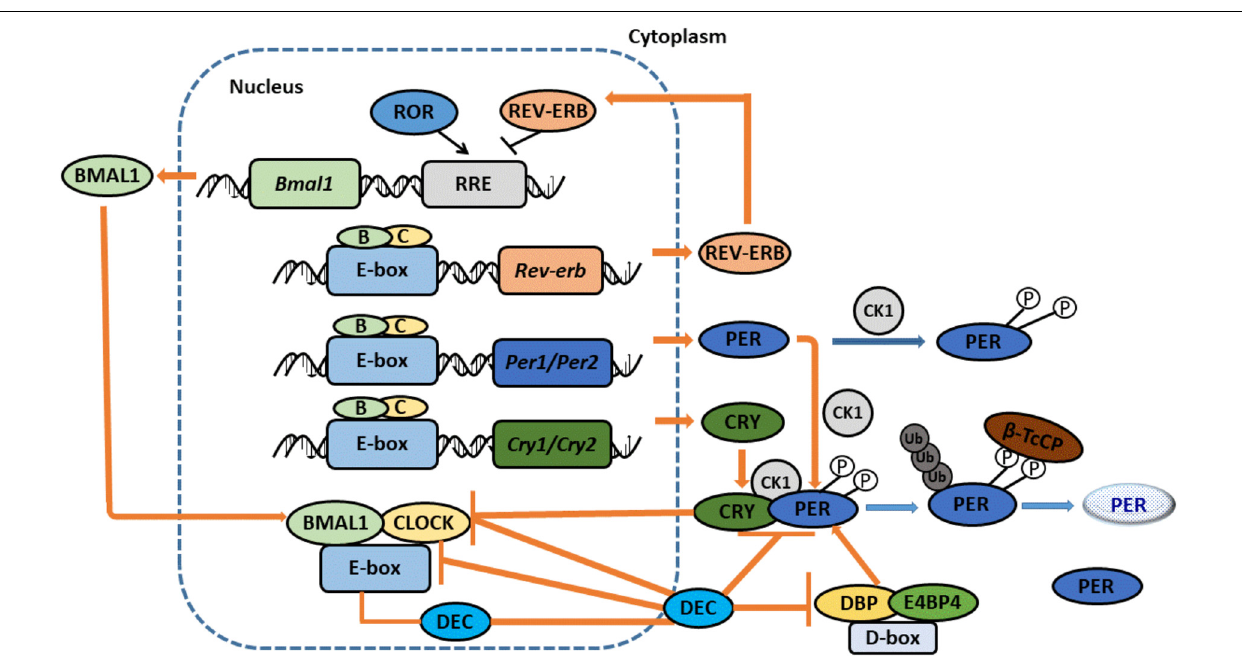
FIGURE 2 | The Molecular Network of Circadian clock. CLOCK and BMAL1 dimerize to stimulate the expression of CCGs with E-box promoter. CLOCK: BMAL1 also activate the expression of the PERS and CRYS. When PERs and CRYs protein levels become high, they dimerize and translocate to the nucleus to repress CLOCK: BMAL1-mediated transcription. PERs and CRYs undergo post-translational modifications that induce their degradation, prepared a new circadian cycle. Proteins REV-ERB α /b, whose levels increase during the day, bind specific responsive promoter elements (RRE) and inhibit BMAL1 transcription. At night, REV-ERB α proteins levels are low, allowing BMAL1’s transcription. DECs also can form an additional loop. DECs repress their own transcription by directly binding to BMAL1 and/or E-box sites. DECs can also repress the transcription of PER1 and DBP. Furthermore, DBP and E4BP4 can bind D-box, activate and suppress transcription to stabilize and fine-tune the PER/CRY feedback loop, and thus promote the formation of the fourth loop. Adopted with modification from Masao